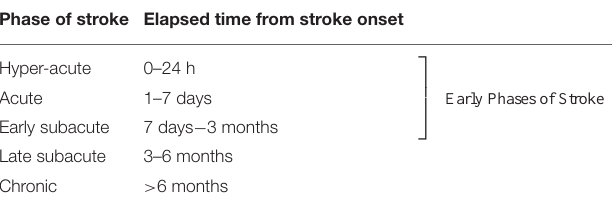
TABLE 1 | Timeframes for phase of